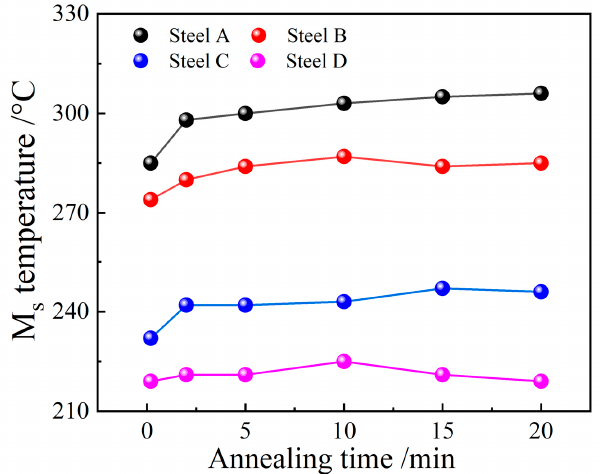
Figure 2. Effect of annealing time on the Ms values for alloys with different compositions.